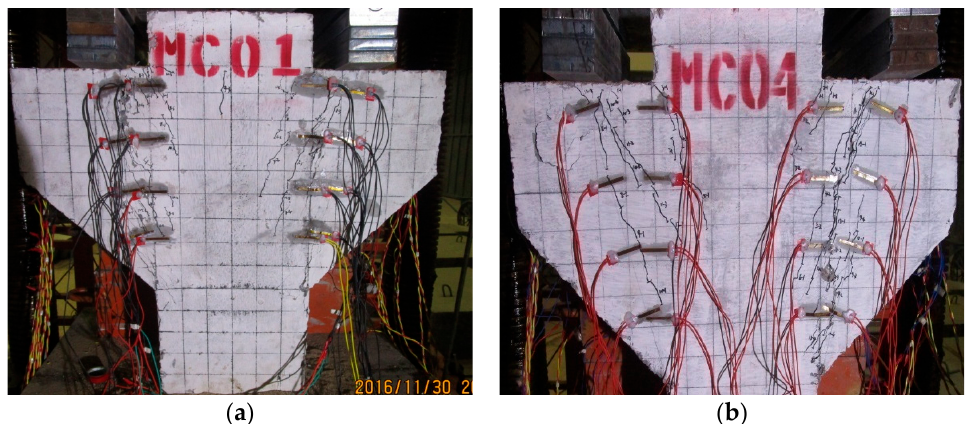
Figure 5. Failure pa tt ern of typical specimens. ( a ) Diagonal shear failure (MC01). ( b ) Diagonal compression failure (MC04).